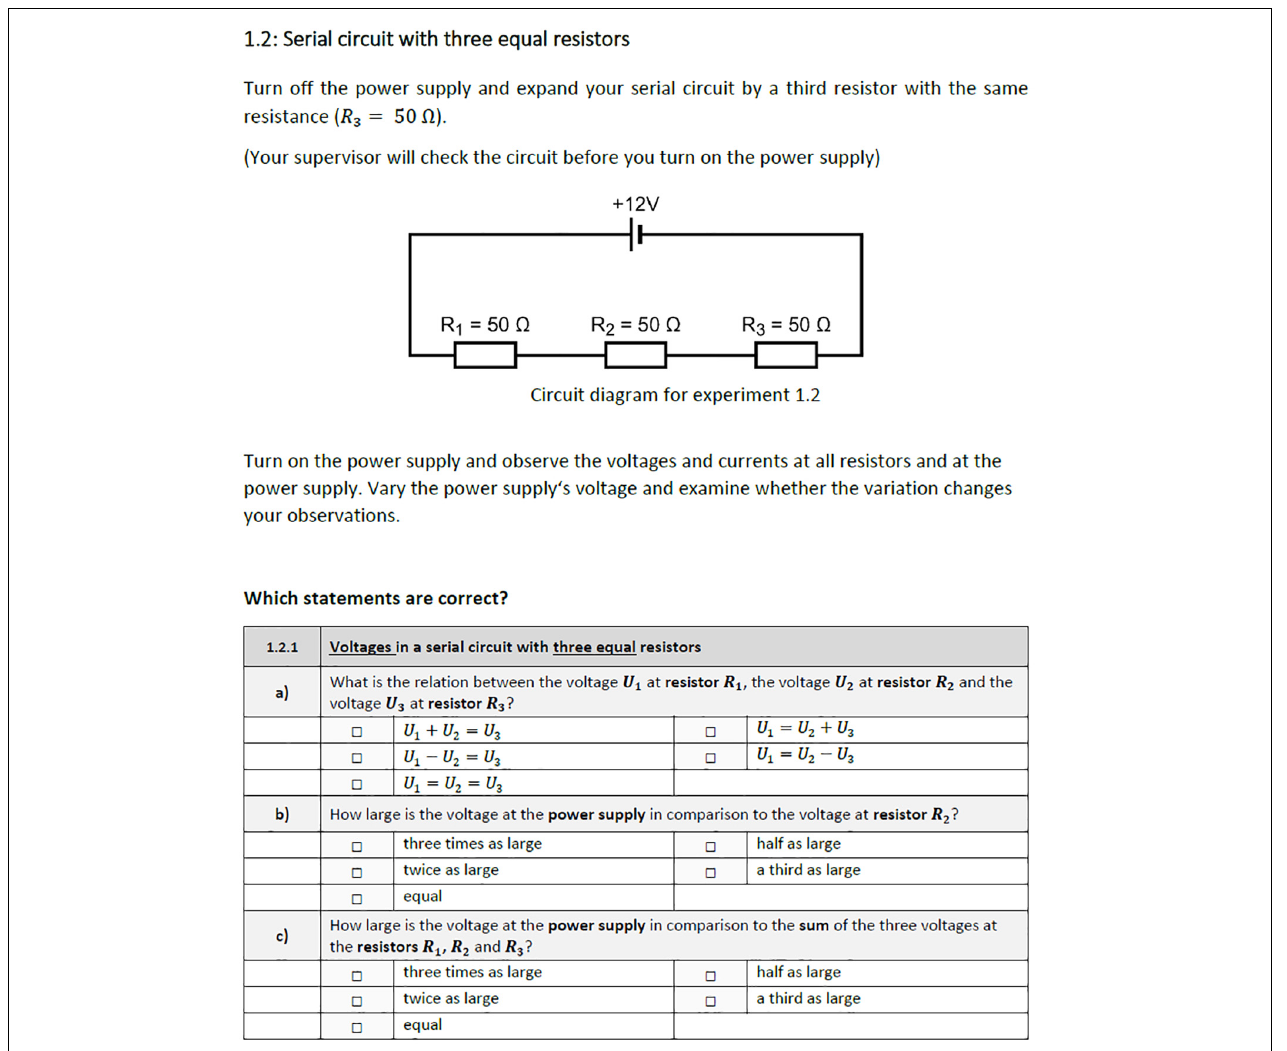
FIGURE 1 | Example of lab work instruction from the work booklet examining a serial circuit consisting of three equal resistors (translated for this